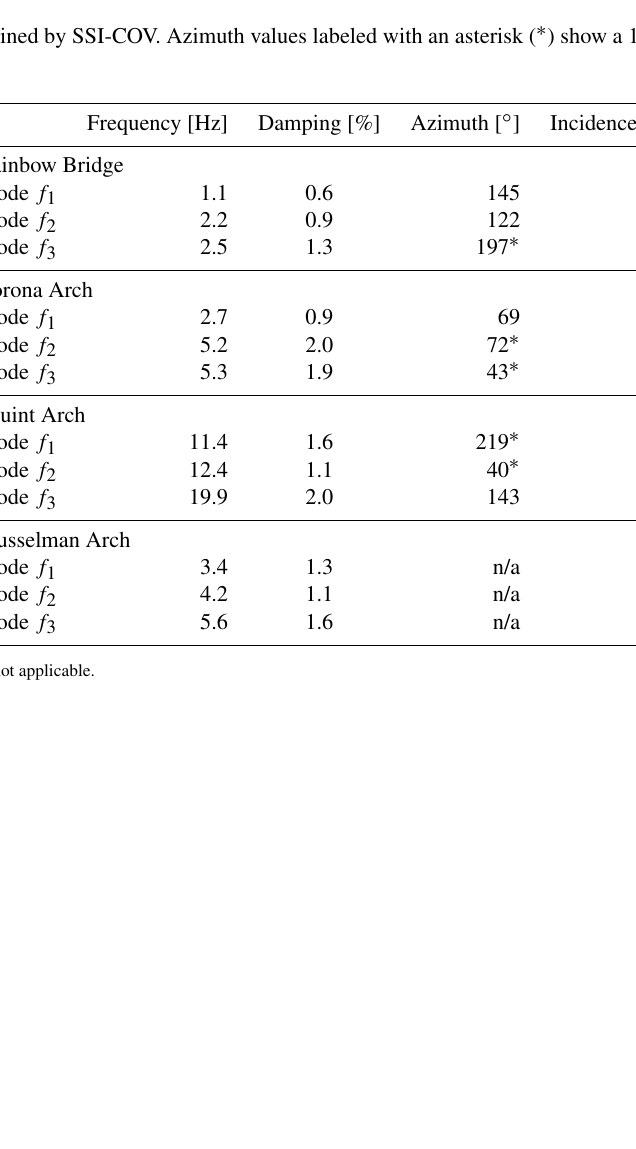
Table A2. Modal parameters obtained by SSI-COV. Azimuth values labeled with an asterisk ( ∗ ) show a 180 ◦ ambiguity compared to EFDD and polarization analysis.